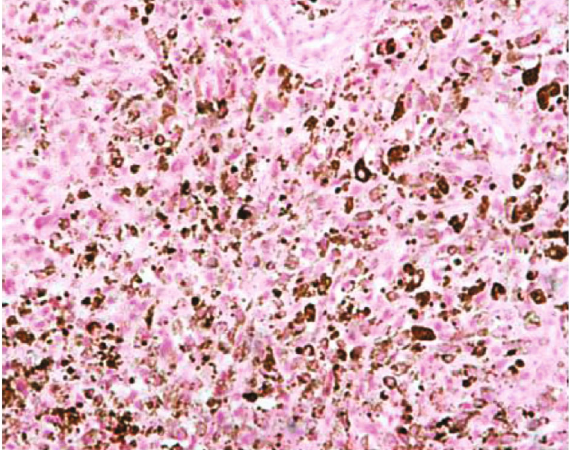
Figure 3: Immunochemical positivity for HMB-45, × 20 magni fi